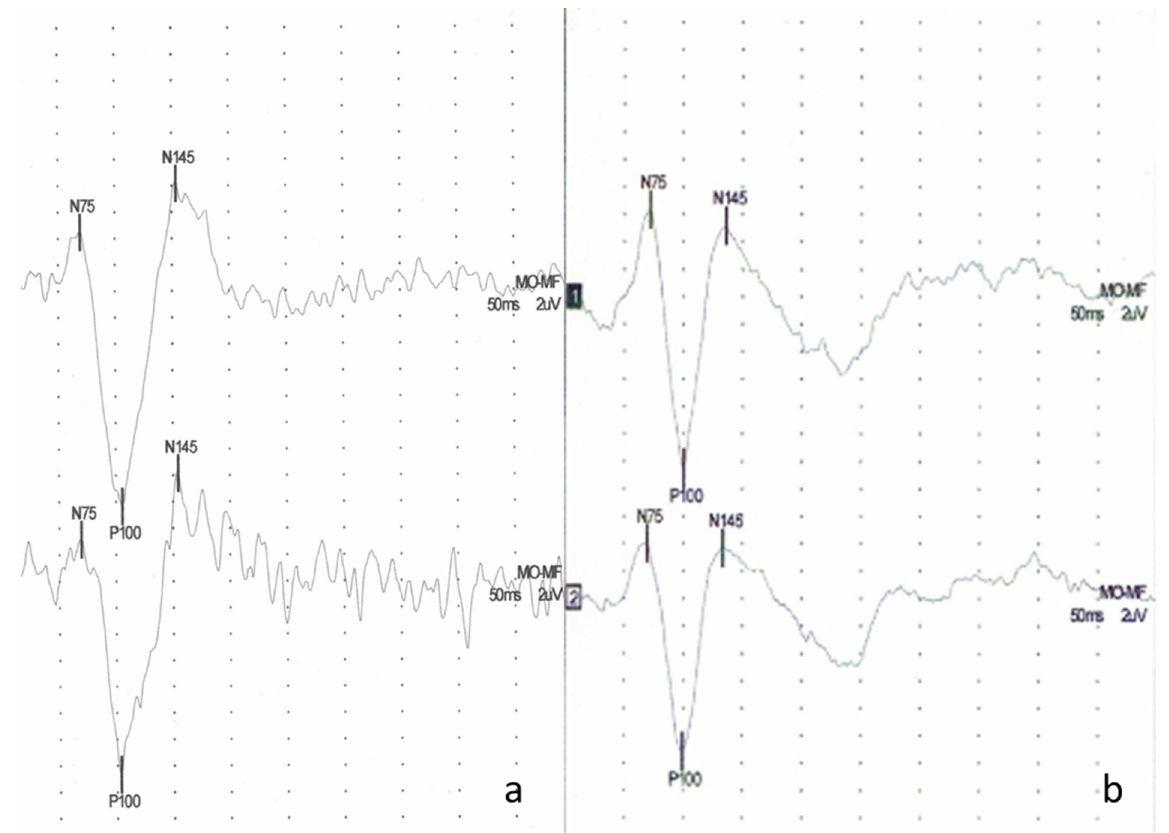
Figure 1. Example of visual evoked potentials (VEP) ( a ) in a patient with pSS—bilaterally normal latency of response P100 (left side 105 ms, right side 103 ms), high P100-N145 amplitude (left side 24.7 μ V, right side Po 23.2 μ V), ( b ) a typical VEP waveform of the control subject bilaterally normal latency of response P100 (left side 100 ms, right side 98.5 ms) and P100-N145 amplitude (left side 17.7 uV, right side 15.0 uV).